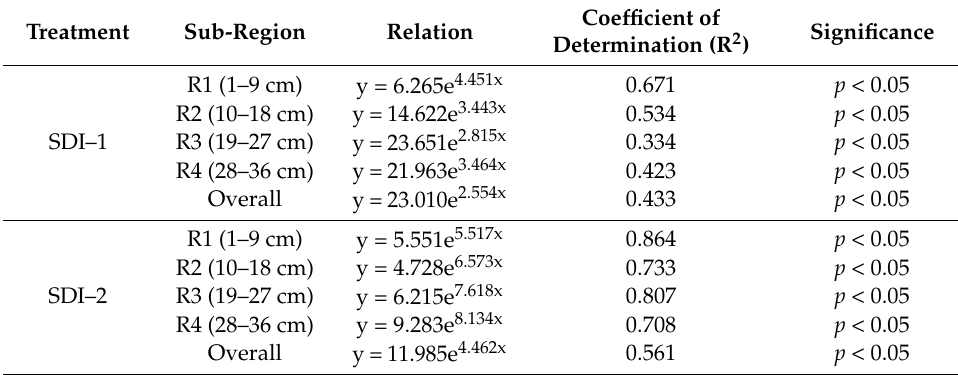
Table 3. Relations between N 2 O fluxes and water filled pore space (WFPS) in SDI irrigated soils with different surface soil wetting